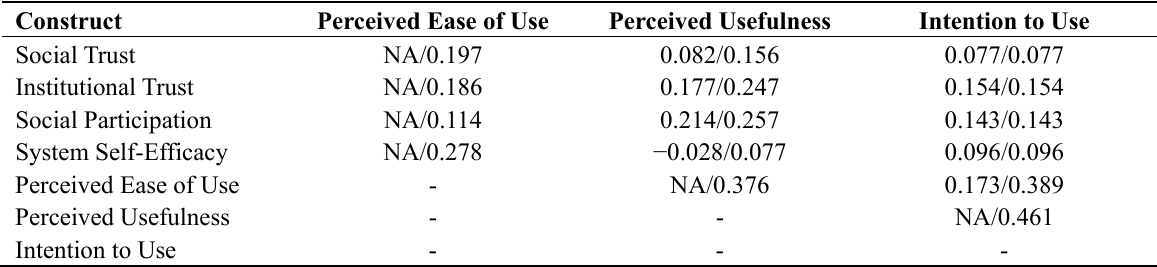
Table 6. Standardized Indirect and Total Effects in the Proposed